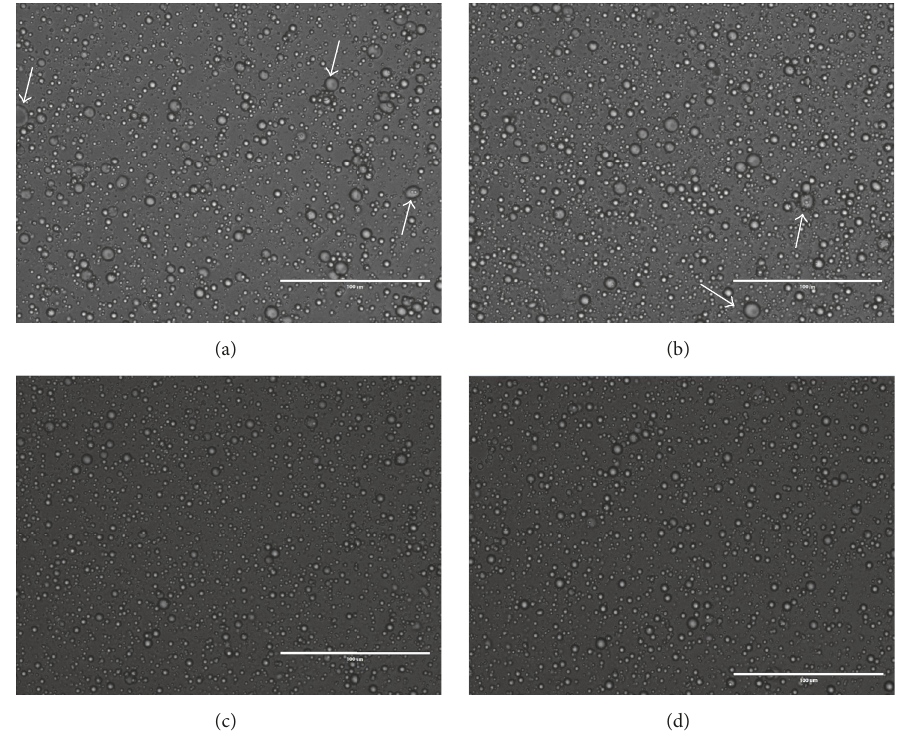
Figure 3: Light micrographs of crude oil body (COBs) emulsions of pecan nuts soaked for 0h (a and b) and 24 h (c and d). The scale bars represent 100 𝜇 m.